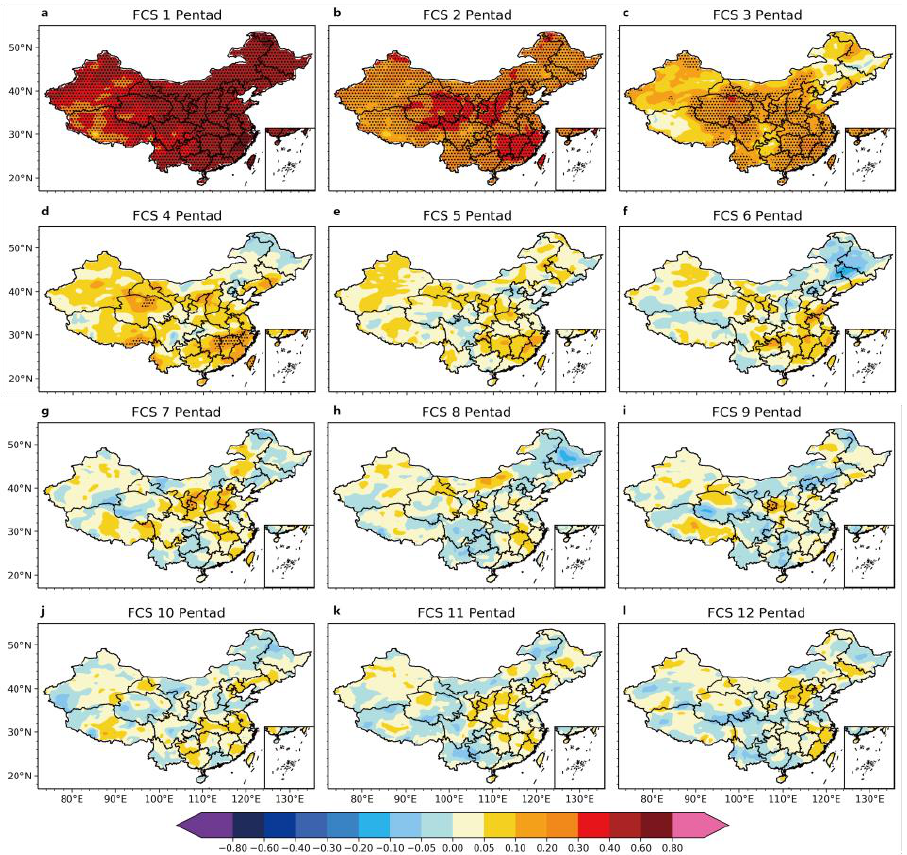
Figure 6. Spatial pattern of the annual average TCC for the leading 1–12 ( a – l , respectively) pentad precipitation forecast of the FGOALS-f2 model from 2000 to 2018. The dotted regions are where the TCC passed the 95% significance test.